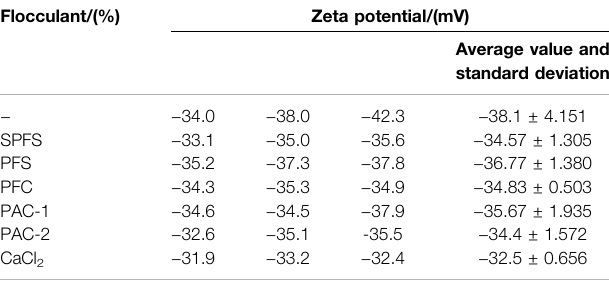
TABLE 5 | Effect of inorganic fl occulant on Zeta potential of PEM drilling fl uid.